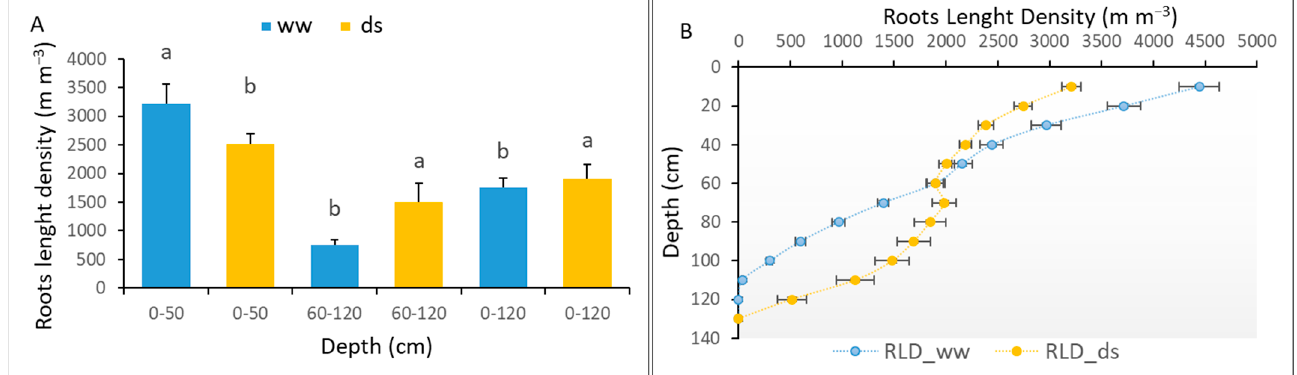
Figure 4. Root length density (RLD) of sorghum varieties under well-watered (ww) and drought stress (ds) conditions at the end of stress. ( A ) RLD distribution according to [0–50], [60–120] and [0–120] depth horizons ( B ) Impact of water deficit on RLD profile. RLD: root length density; ww: well-watered; ds: drought stress. Data are mean +/ − standard error, Significant differences are indicated by different letters (a and b).